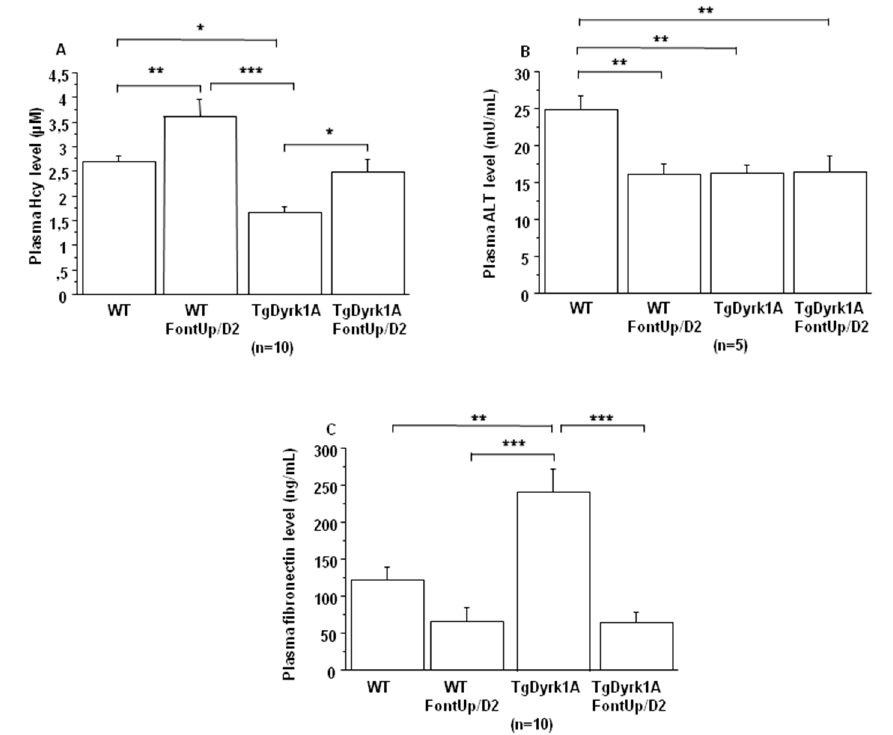
Figure 3. Comparison of plasma hcy ( A ), ALT ( B ) and fibronectin ( C ) levels obtained from WT and mice overexpressing Dyrk1A (TgDyrk1A) after oral gavage of D2 FontUp ® during two days (FontUp / D2). The values are mean ± SEM of n (number of mice) mice. Statistical analysis was done as mentioned in data analysis. * p < 0.05; ** p < 0.005; *** p < 0.0001.